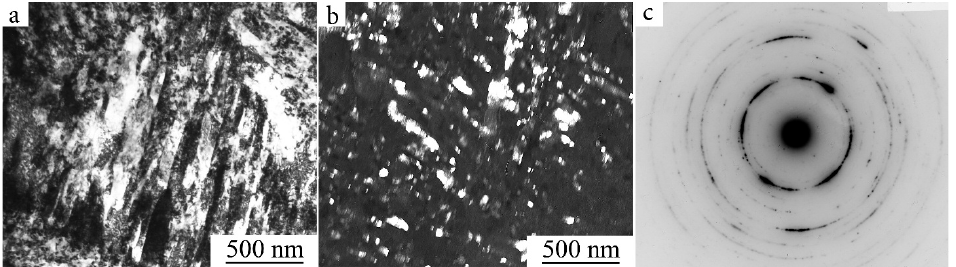
Figure 20. ( a ) Bright- and ( b ) dark-field TEM images of the microstructure, and ( c ) the corresponding SAED pattern (SD 1 µm), taken from the Ti 49.5 Ni 50.5 alloy after its MPR by 30% and PDHT at 673 К for 1 h.